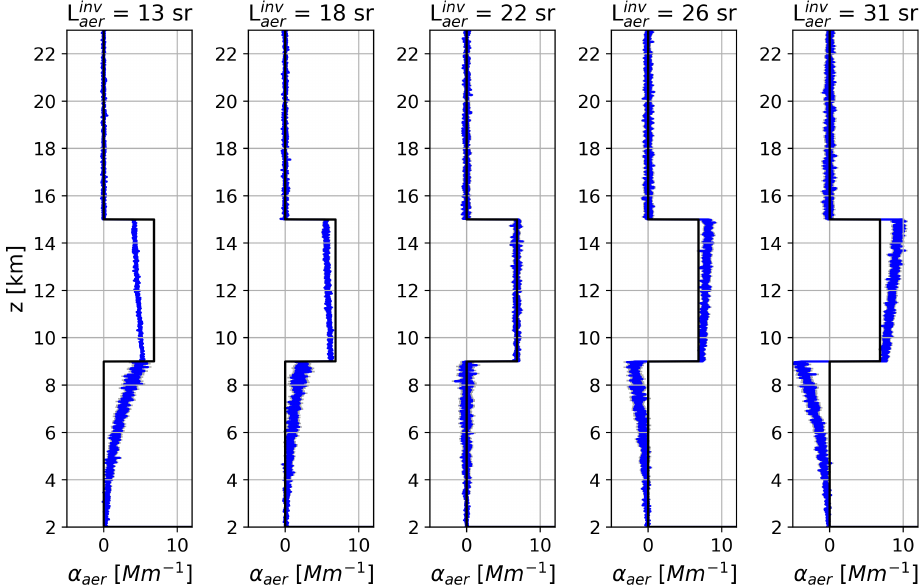
Figure 6. Examples of extinction profiles obtained with a range of values of L inv aer from 13 to 31 sr are shown in blue, with the reference value used in the simulation in black. The simulation was for the case of κ = 10,000 and ν =